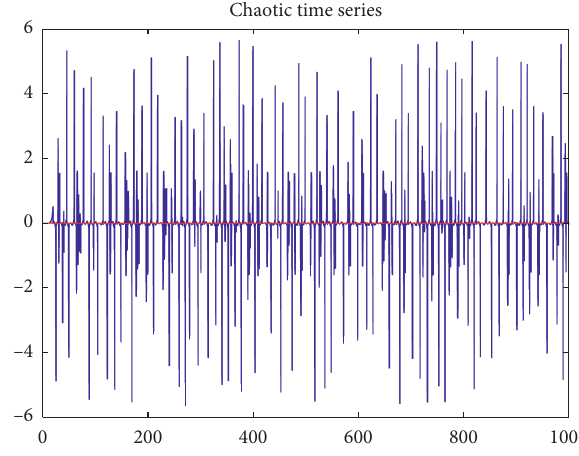
Figure 3: Chaotic time